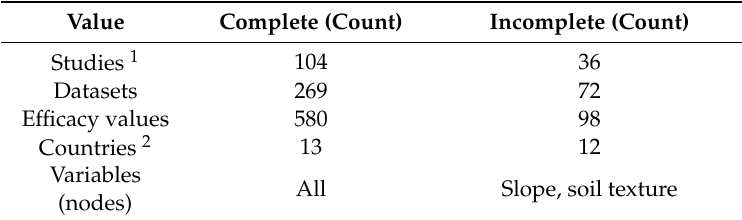
Table 2. Completeness of literature values.